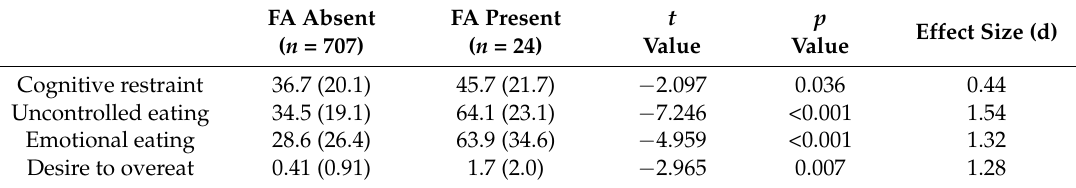
Table 6. Associations of the 18-item Three-Factor Eating Questionnaire (TFEQ R-18) scores and frequency of desiring to overeat with the J-YFAS 2.0-diagnosed food addiction (FA) severity. p FA Absent Mild FA Moderate FA Severe FA F Pairwise Effect Size ( n = 707) ( n = 8) ( n = 9) ( n = 7) Value Value Difference a ( η 2 ) Cognitive restraint 36.7 (20.1) 43.1 (17.8) 48.6 (24.3) 45.2 (25.6) 1.56 0.197 0.01 Uncontrolled eating 34.5 (19.1) 56.0 (24.5) 62.5 (20.5) 75.1 (23.2) 18.80 <0.001 1 < 2,3,4 0.07 Emotional eating 28.6 (26.4) 43.1 (37.3) 74.1 (26.1) 74.6 (34.4) 16.06 <0.001 1 < 3,4 0.06 1 < 3, 4; Desire to overeat 0.4 (0.9) 0.6 (1.2) 1.8 (1.5) 2.7 (2.9) 19.53 <0.001 0.07 2 < 4 Analysis of variance was used. TFEQ R-18 scores and frequency of desiring to overeat are shown as mean (standard deviation). The numbers of missing responses were as follows: TFEQ R-18 cognitive restraint, n = 8 (7 from FA absent, 1 from Moderate FA); uncontrolled eating, n = 12 (11 from FA absent, 1 from Moderate FA); emotional eating, n = 2 (all from FA absent); and desire to overeat, n = 1 (from FA absent). a Pairwise differences were of p < 0.05